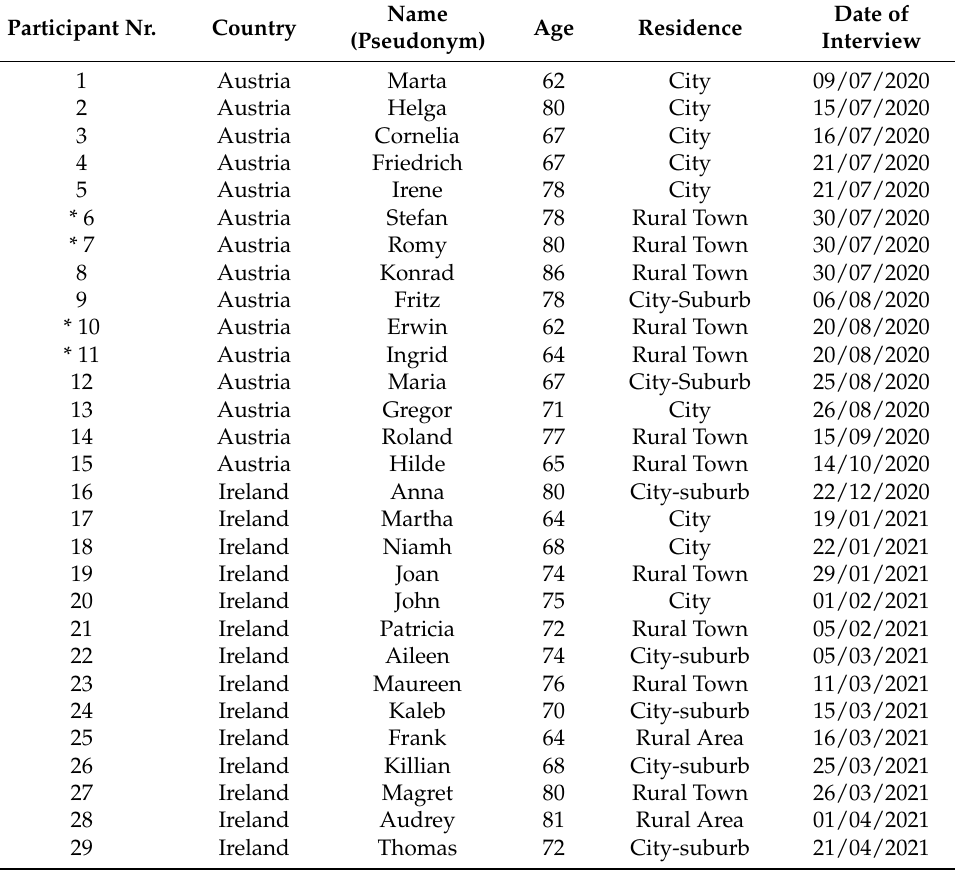
Table 1. Overview participant sample. Participant